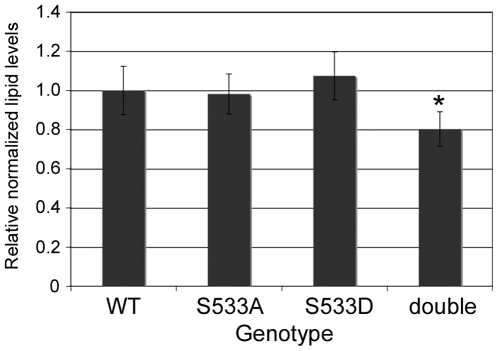
Flies lacking Akt phosphorylation sites on both Tsc1 and Tsc2 are slightly lean.Triglyceride levels normalized to total body protein for Tsc129 homozygotes rescued by ubiquitous expression of Tsc1WT (“WT”), Tsc1S533A (“S533A”) or Tsc1S533D(“S533D”), or flies homozygous for both the Tsc129 and Tsc2192 mutations rescued to viability by expression of both Tsc1S533A and Tsc2T437A/S924A/T1054A/T1518A (“double”). * indicates statistical significance (ttest = 0.01).